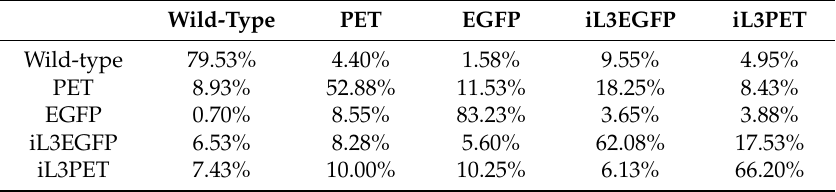
Table 3. PLS predictions of the riboswitch set. Confusion matrix of strain prediction using binary coding .